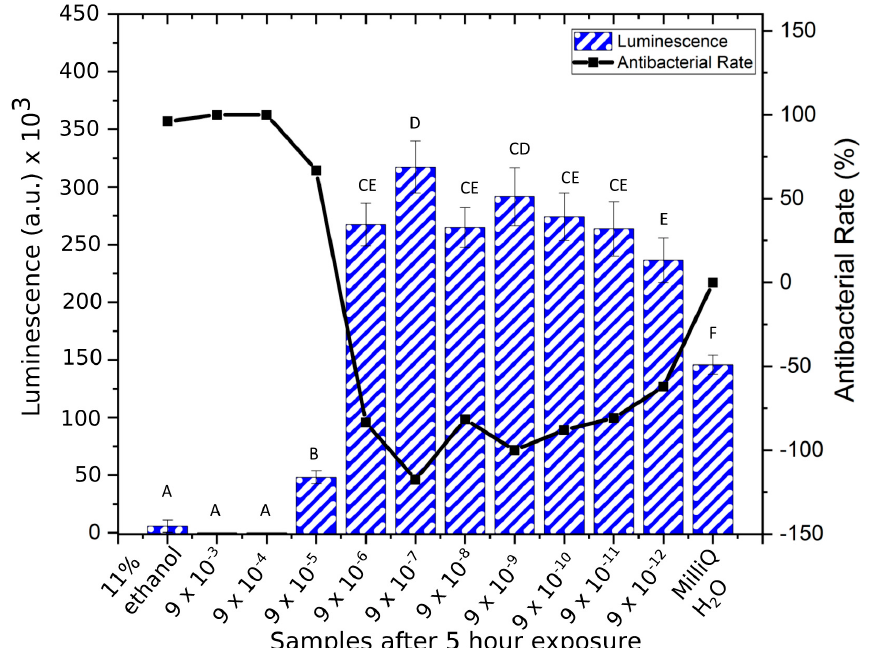
Figure 2. Luminescence counts (mean ± SD) of XEN43 bacteria after 5 h for all sample solutions, the negative (MilliQ) and positive (11% ethanol) controls, and the corresponding antibacterial rate. Brown–Forsythe: F (1, 11) = 1.48, p = 0.1802. One-way ANOVA: F = 238.9 ( p < 0.001). Note: Samples indicated with the same letter are non-significantly different, e.g., “A” denotes that samples indicated with “A” are non-significantly different ( p > 0.05). This also applies to samples indicated with “B”, “C”, “D”, “E”, and “F”. In addition, e.g., “CE” denotes non-significantly different to samples indicated with “C” and “E”. Conversely, samples indicated with di ff ering letters, denotes statistically significantly di ff erent ( p <